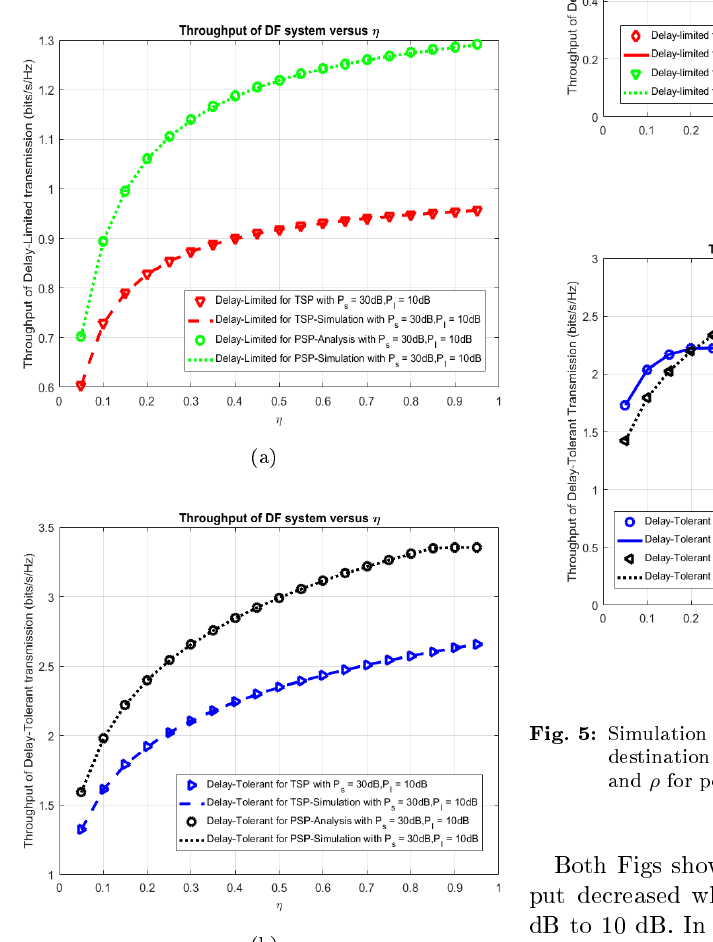
Fig. 4: Simulation and analytical throughput versus η at the destination node.